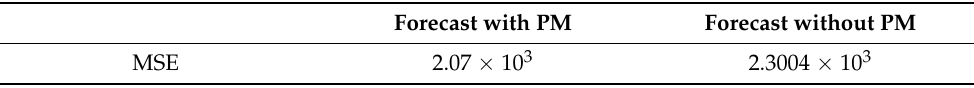
Table 2. Accuracy of the load demand forecast of each model with and without considering particu- late